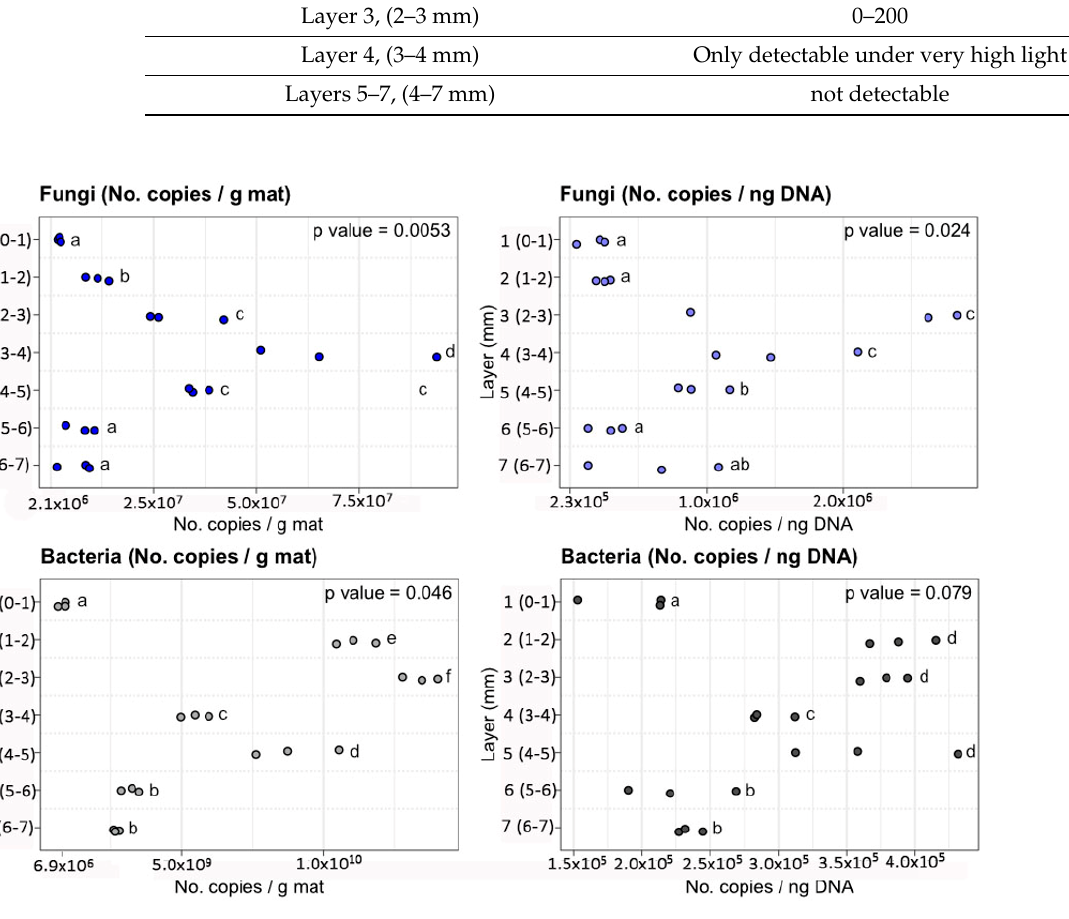
Figure 2. Copies of 18S rRNA fungal (top panels) and 16S rRNA bacterial (bottom panels) genes recovered, per g of microbial mat (left panels) or ng of DNA (right panels), quantified by qPCR in hypersaline microbial mat sections from different depths. Different letters between layers denote statistical differences, according to Conover-Iman and Kruskal–Wallis tests. Table 2. Average ± standard deviation of the number of copies (per g of mat and ng of nucleic acid) of the fungi and bacteria in different layers of